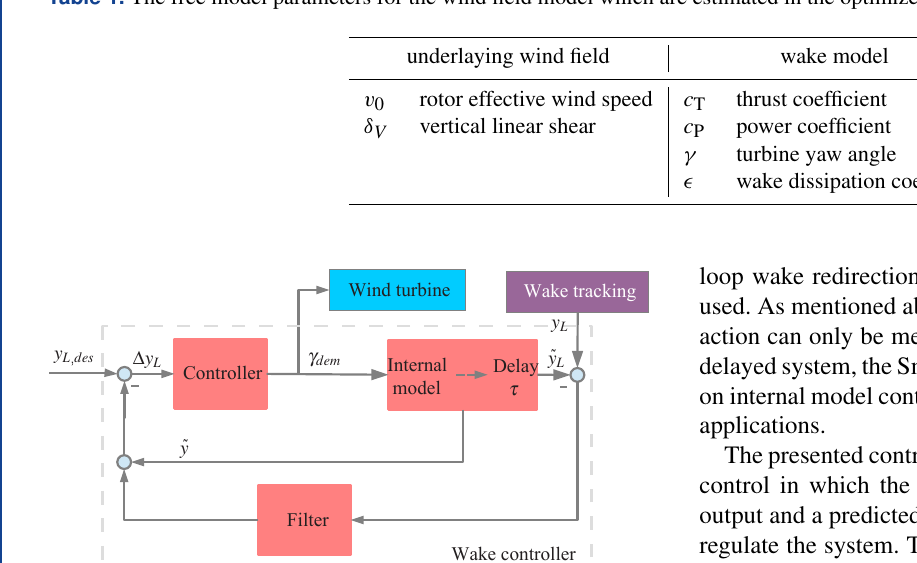
Table 1. The free model parameters for the wind field model which are estimated in the optimizer.